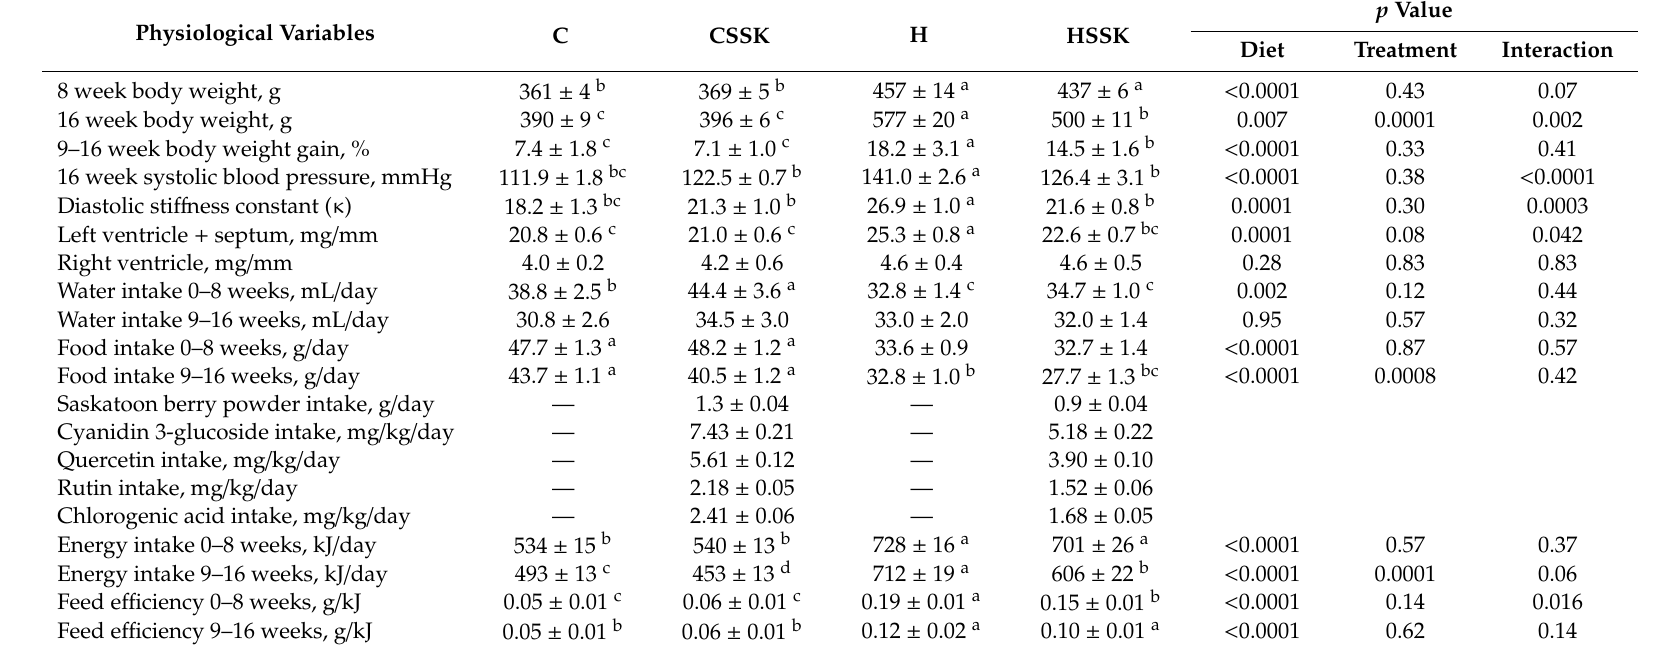
Table 1. Physiological responses to Saskatoon